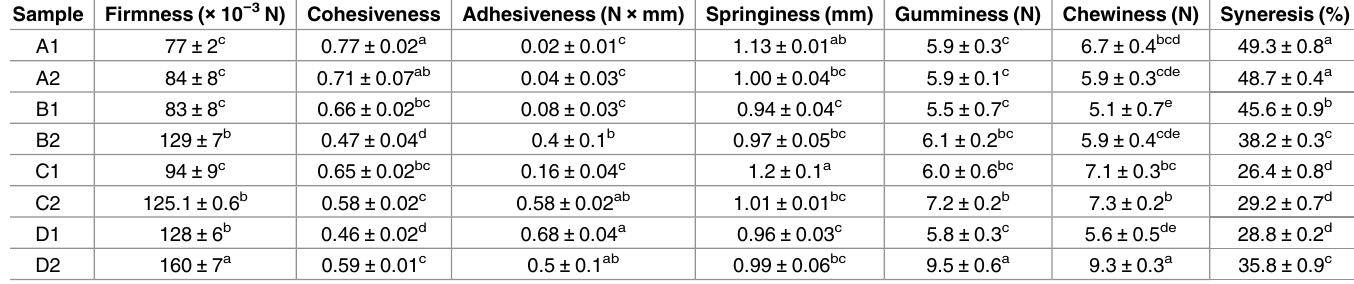
Table 4. Texture parameters and syneresisof yogurts with and without curdlan and submitted or not to heat treatment. Values indicate mean ±